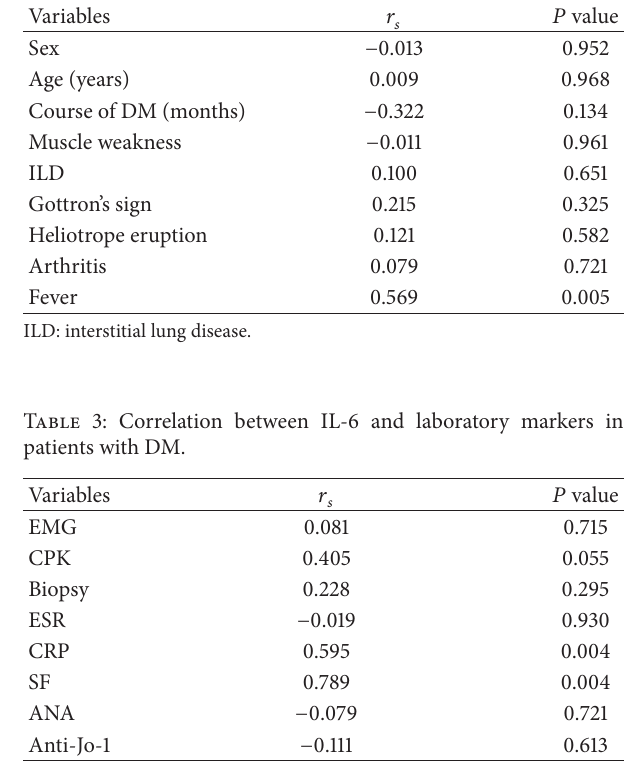
EMG: electromyogram, CPK: creatine phosphokinase, ESR: erythrocyte sedimentation rate, CRP: C-reactive protein, SF: serum ferritin, and ANA: antinuclear